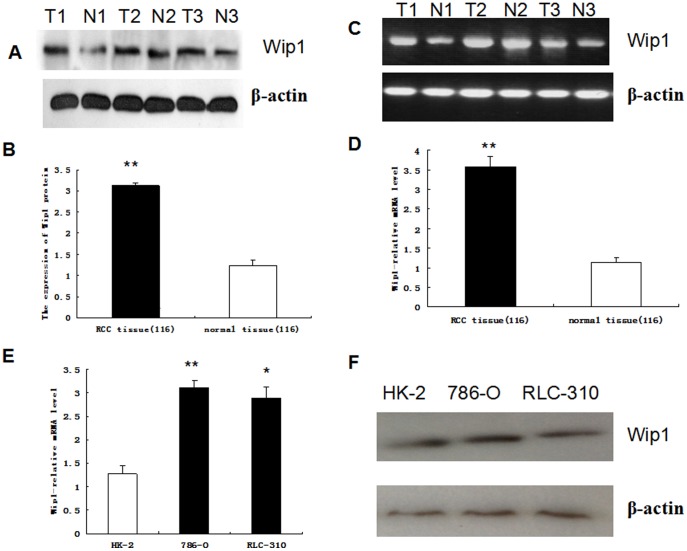
High expression of Wip1 in RCC Tissue and cell lines.Expressions of Wip1 protein and mRNA in representative pairs of matched normal renal tissues (N) and ccRCC tissues (T) were assessed by western blotting (A, B) and qRT-PCR(C, D), respectively. Wip1 expression in immortalized normal human proximal tubule epithelial cell line HK-2 and two types of RCC cell lines (786-O, RLC-30) was determined by qRT-PCR (E),western blotting (F) respectively. β-actin served as a loading control. Data were shown as mean±SD, **P<0.001, *P<0.05.